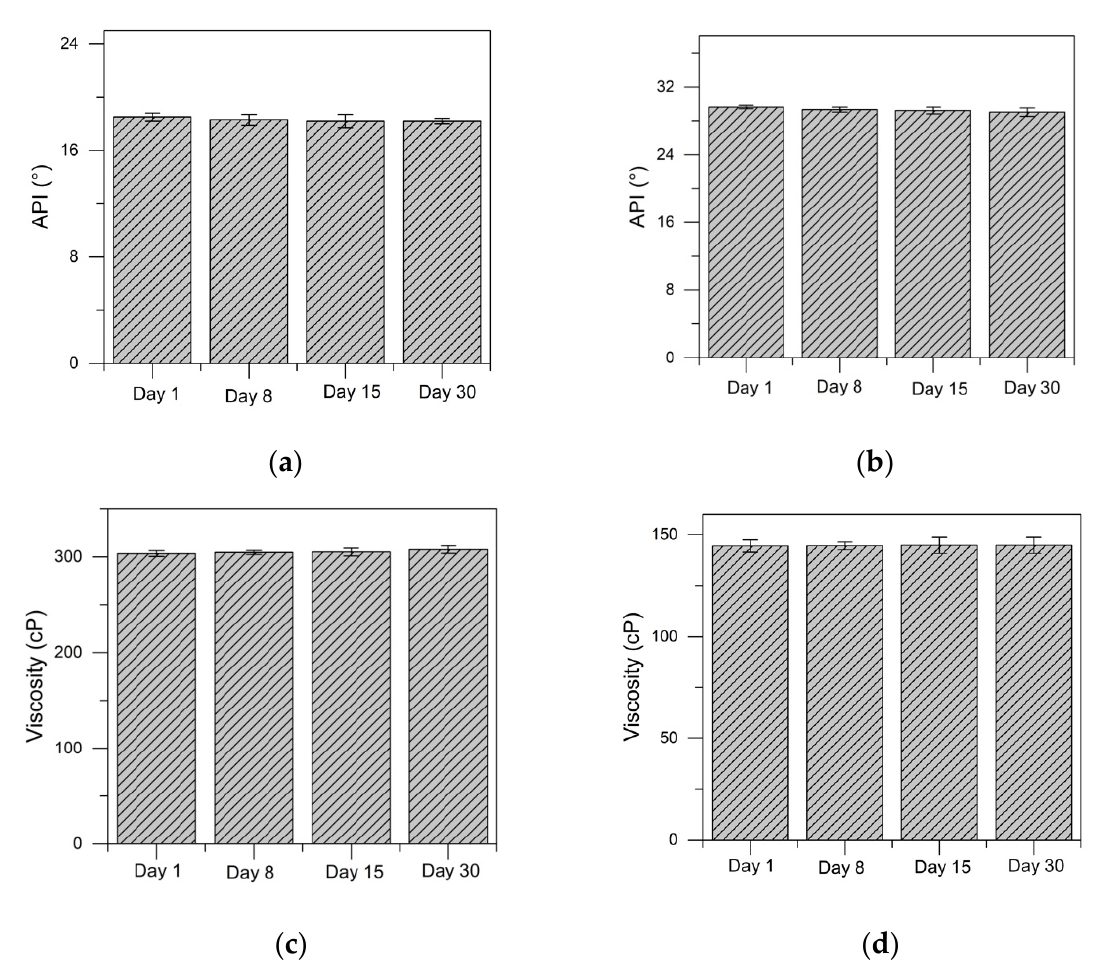
Figure 3. Perdurability of crude oil for ( a , c ) for HO1 and ( b , d ) for HO2, for the effluents recovered after the 12 h soaking of the nanofluid in the porous medium.